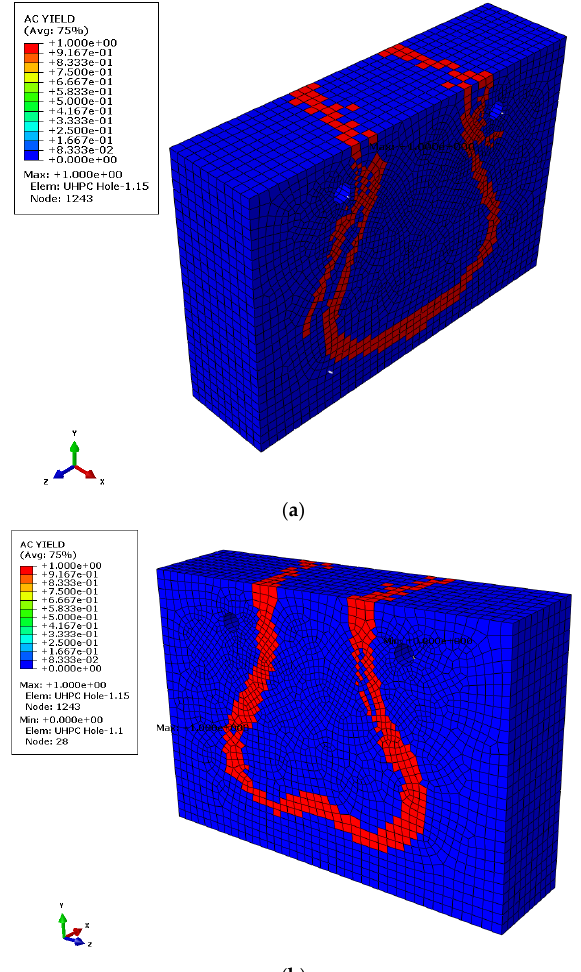
Figure 20. Actively yielding concrete failure/fracture for ( a ) reaction (front) side and ( b ) forcing (rear) side.